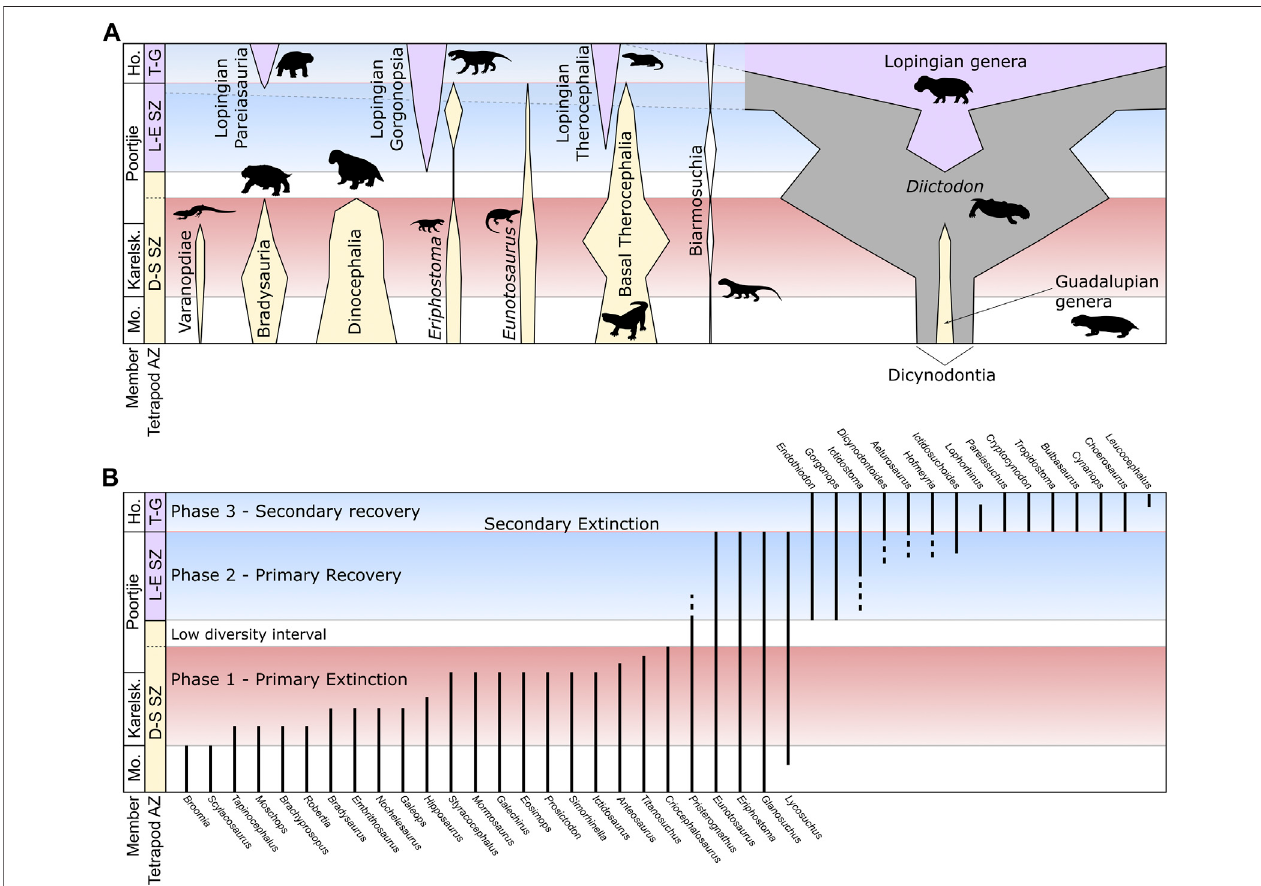
FIGURE 4 | Illustrative section through the Abrahamskraal-Teekloof Formation boundary showing (A) the relative abundances of selected taxa, corresponding to numbers of specimens (see Appendix 2), and (B) a summary of the stratigraphic ranges for individual genera. Genera shown in (B) taken from Day and Rubidge (2020) and Day and Smith (2020) but excludes range-through taxa ( Diictodon feliceps , Pristerodon mackayi , Emydops arctatus , Rhinesuchus whaitsi , Rhinesuchoides tenuiceps ) and taxa with single occurrences of uncertain position (Nycteroleters indet., Australothyris smithi , Hipposaurus brinki , Agnosaurus pienaari , Moschognathus whaitsi , Galepus jouberti ). Abbreviations: Ho, Hoedemaker; Karelsk, Karelskraal; Mo, Moordenaars.